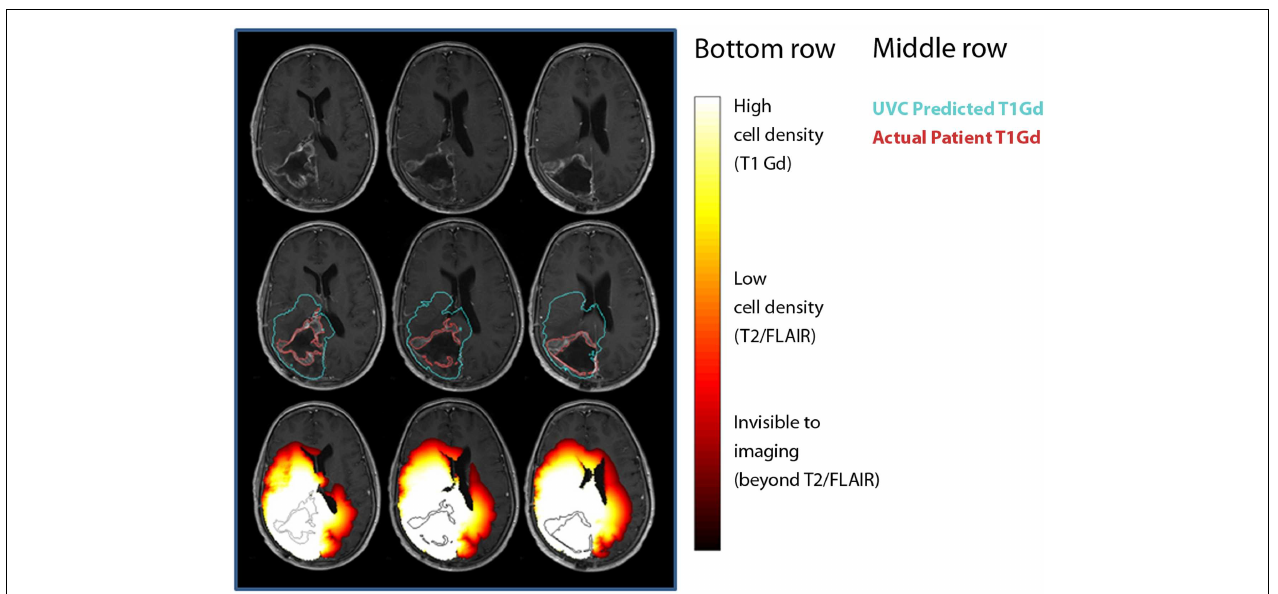
prediction ofT1-Gd area (aqua).Third row: UVC tumor cell densities overlaid (white, high cell density; red, low cell density) on scan withT1-Gd measured tumor outline